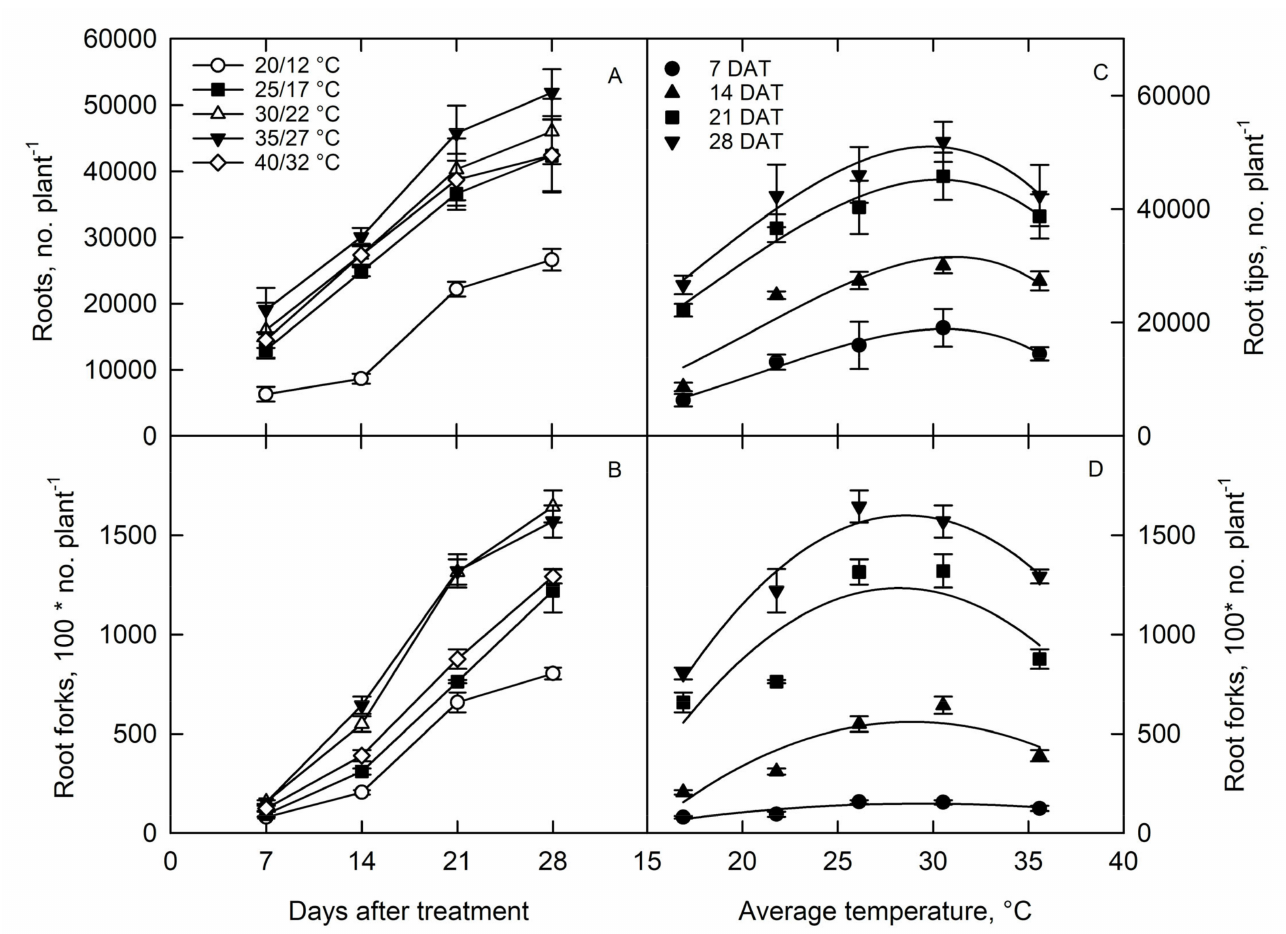
Figure 5. Temporal trends of corn root developmental parameters ( A ) root tips and ( B ) root forks under five differing temperature treatments over days after treatment and estimated mean root developmental rates measured at weekly intervals presented as a function of average temperature for ( C ) root tips and ( D ) root forks as a function of temperature at different times periods. A modified beta function model best-described biomass accumulation rates of various root developmental rates as a function of temperature. All values are the mean ± standard error of six replications at each harvest under each